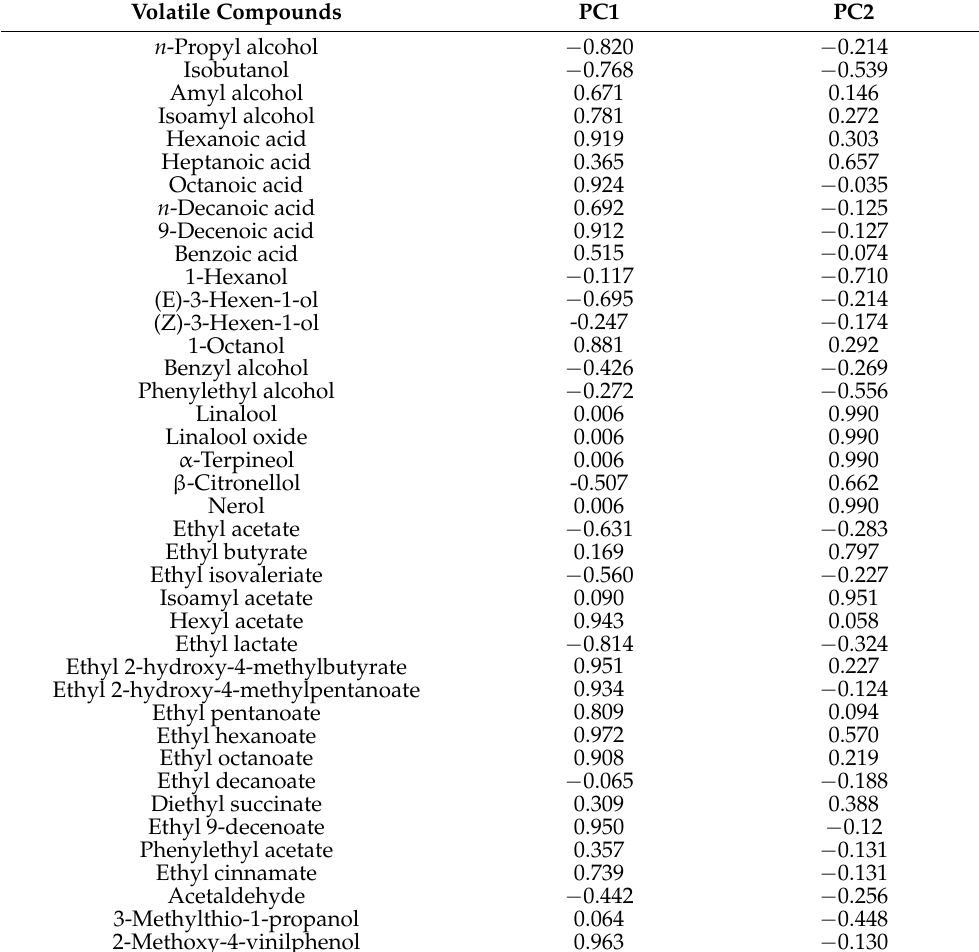
Table 4. Loadings of principal components of volatile compounds’ OAVs in Palomino fino wines. Volatile Compounds PC1 PC2 n -Propyl